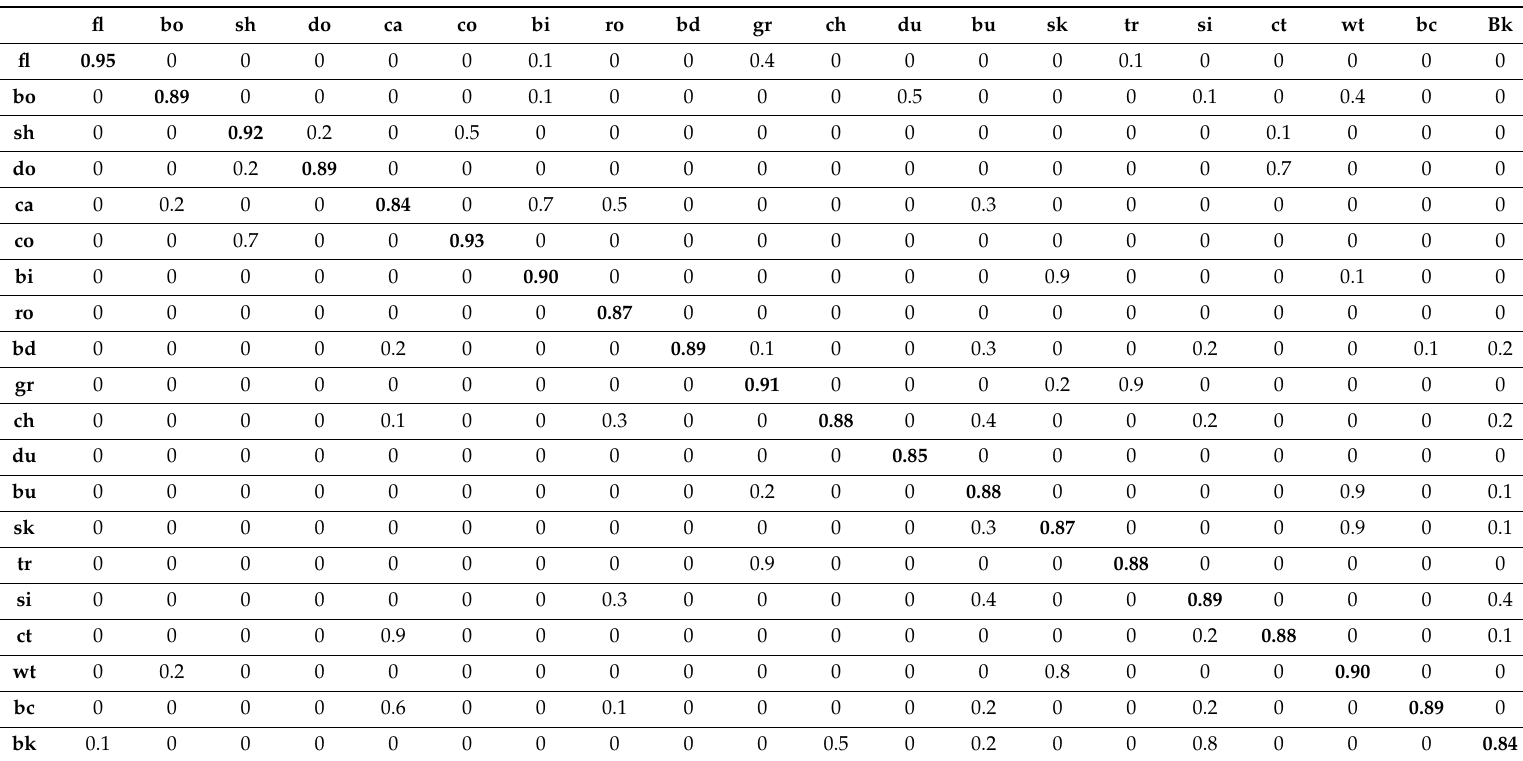
Table 4. Confusion matrix of accuracy scores for object classification in outdoor scenes for the proposed approach and the MSRC dataset.